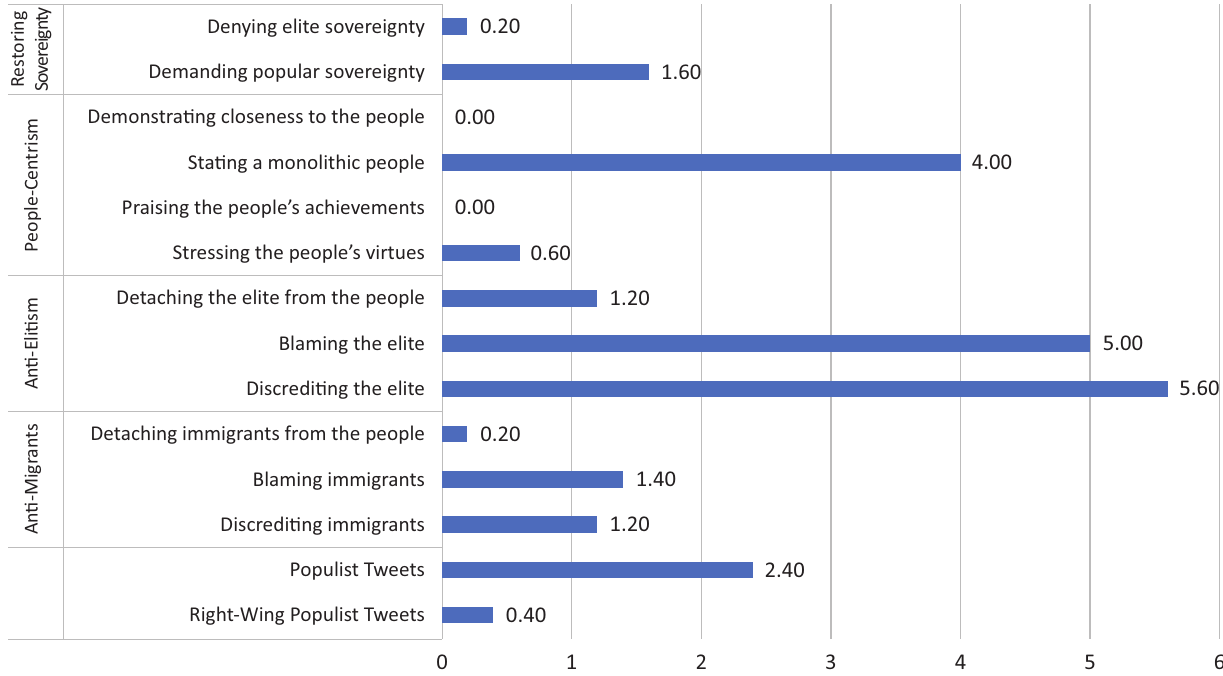
Figure 2. Share of all (right-wing) populist tweets and all populist communication strategies among the widest-reaching tweets (N = 500